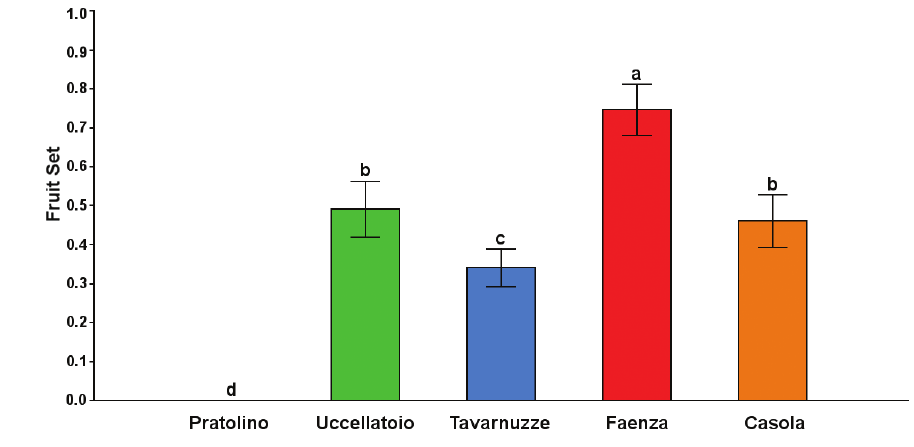
Figure 2. Box-chart of fruit set amongst the studied Bellevalia webbiana populations (confidence inter- val, 95%). Different letters indicate statistically significant differences at 0.01 level.